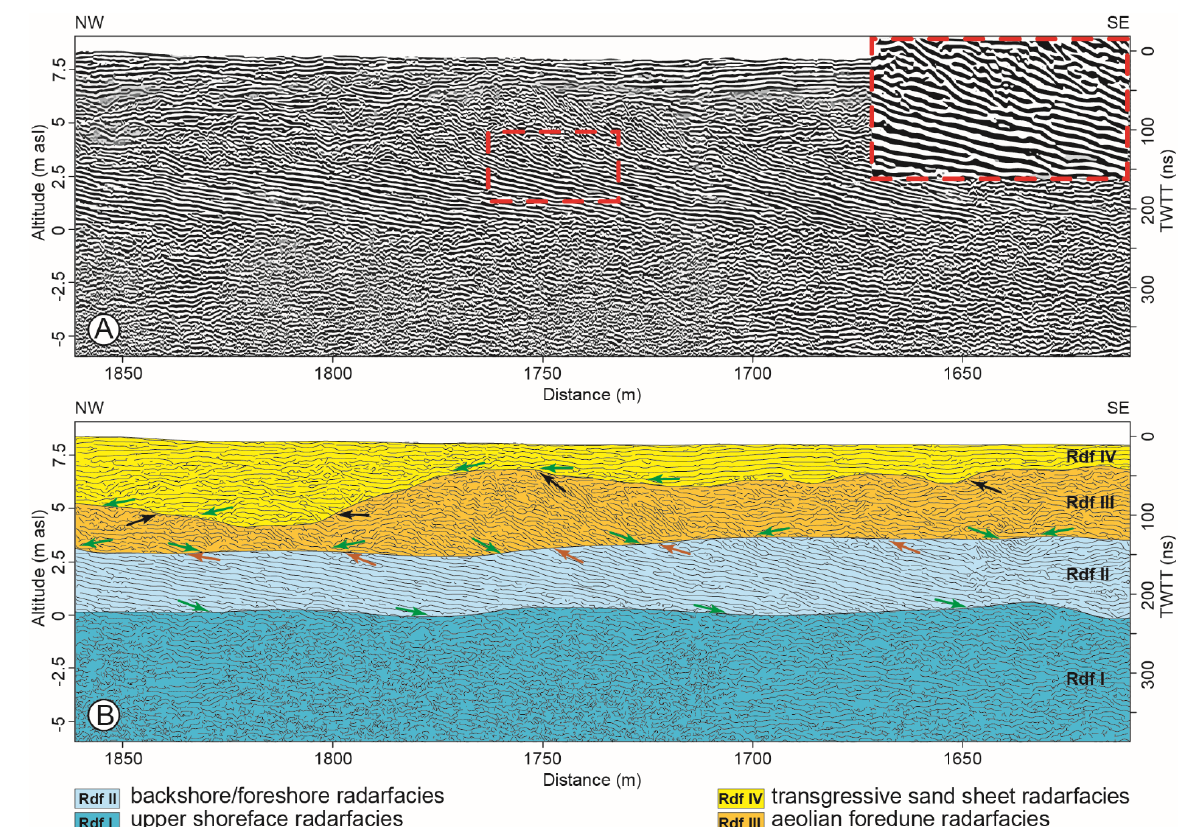
Figure 3. The short interval of the GPR profile above was performed at the Arroio do Sal (see location in Figure 1). ( A ) Processed section showing, in the dashed red rectangle, the contact between the foredune and the backshore (zoom in for a better observation); ( B ) Interpreted section showing the four radarfacies. The arrows represent the reflection terminations (toplap: orange, downlap: green, truncations: black). See insertion of this GPR interval in the large and stacked GPR record of Figure 5B.